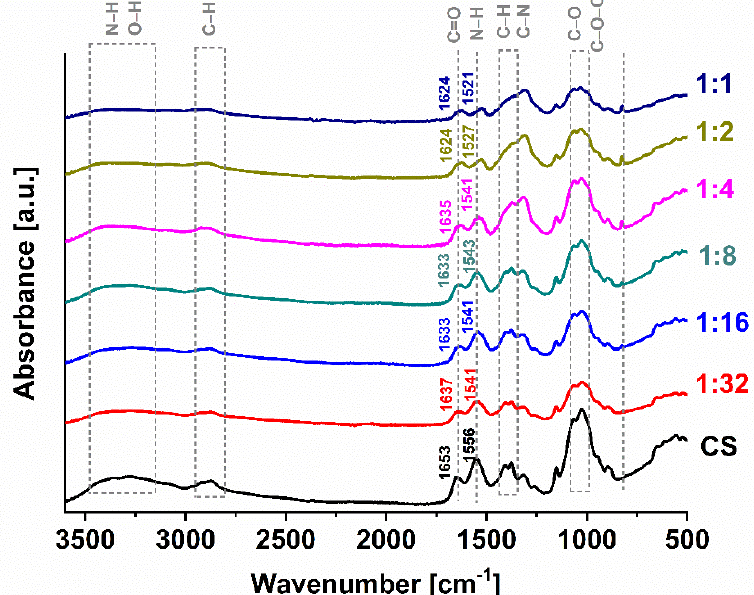
Figure 2. FTIR spectra of CS and Ga (III)-CS complexes. The related bands are discussed in the